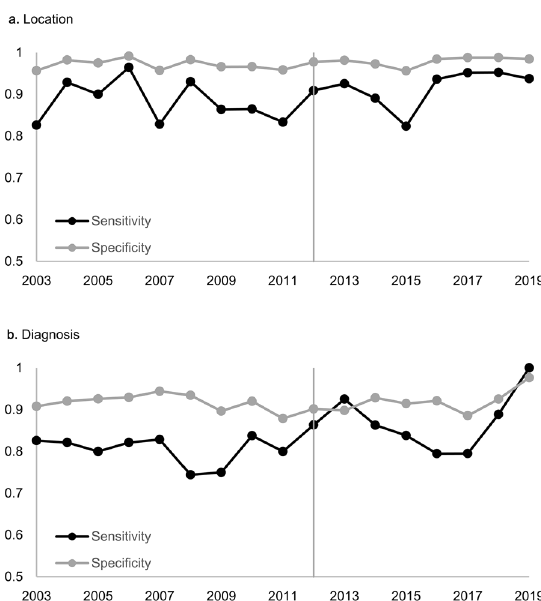
Figure 2. Validity according to the period of MRI examinations. ( a ) For the location, sensitivity and specificity showed no significant difference before and after 2012 (P = 0.943, 0.134). ( b ) For the diagnosis, there was no significant change in sensitivity and specificity ((P = 0.264, 0.581).